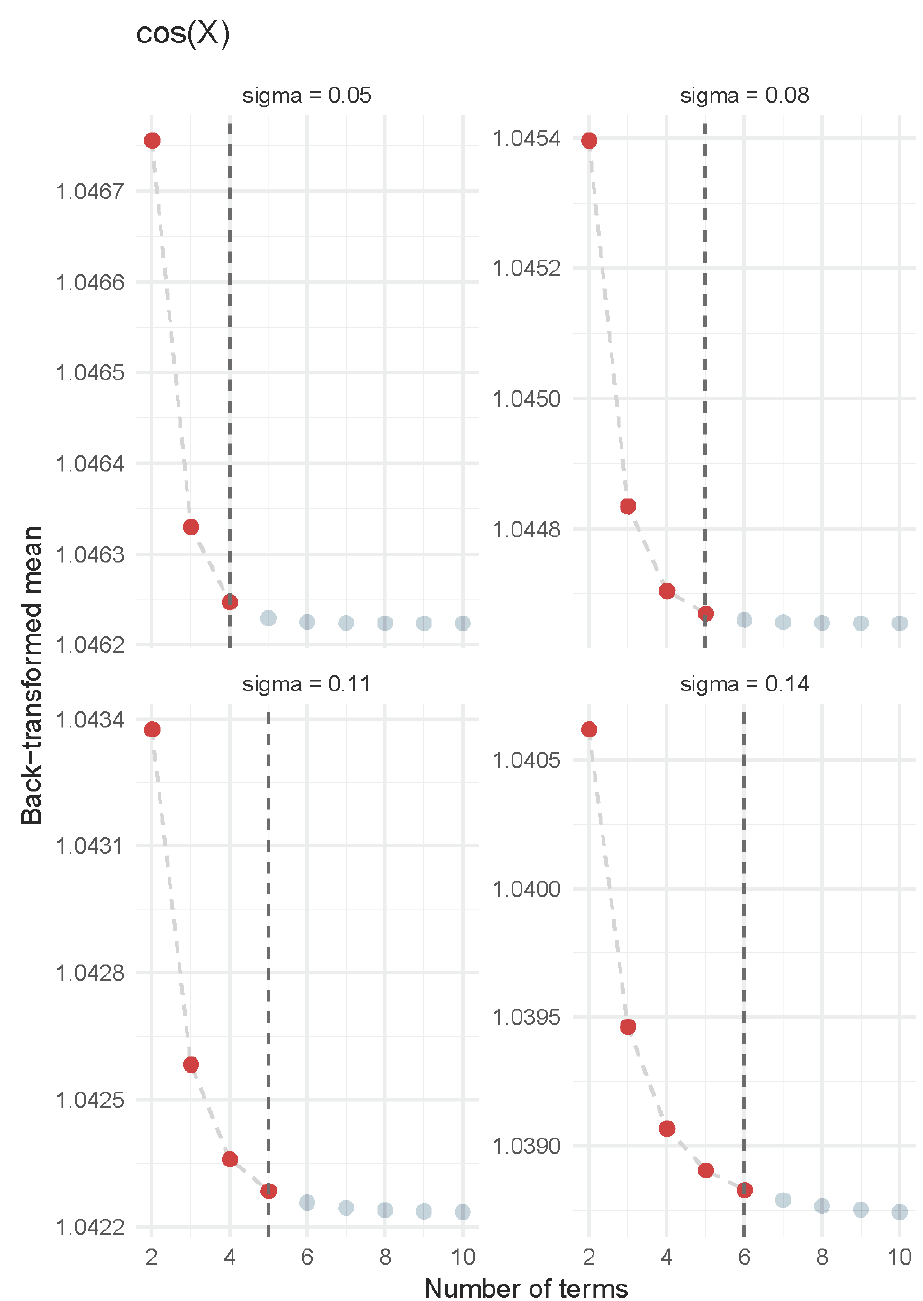
Figure 2. Convergence of the cosine transformation according to the number of terms in the Taylor series expansion. The vertical dotted line identifies the number of terms for which two consecutive di ff erences between Taylor series estimates are less than the preset value of the order of 10 − 5 .